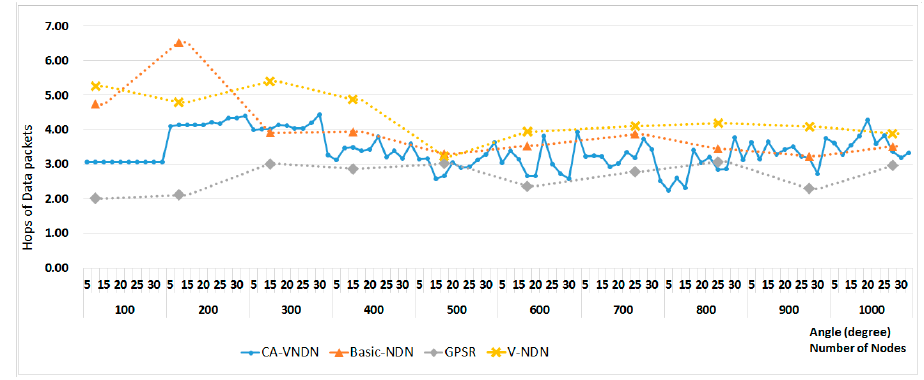
Figure 17. Hops of Data packets vs. the number of nodes and suppression angle.